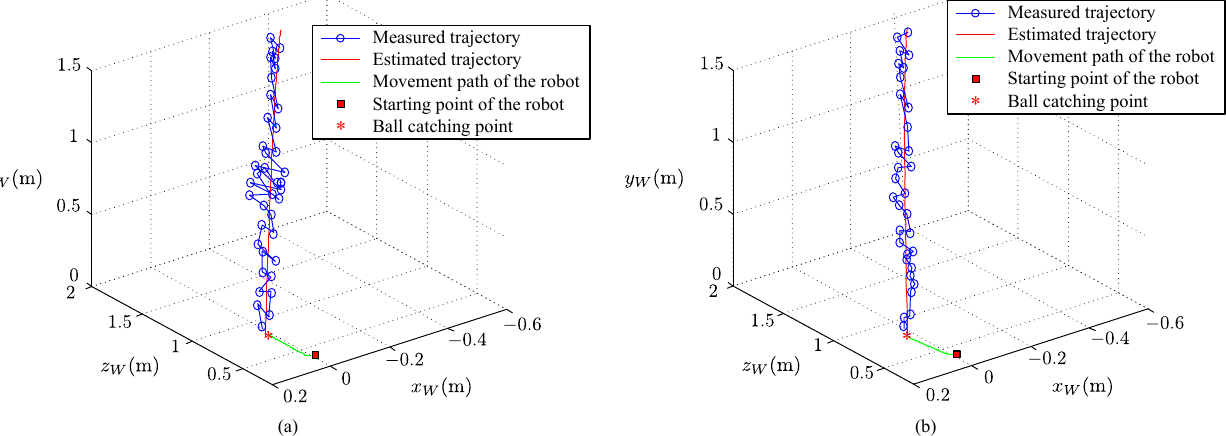
Figure 23. The ball’s trajectories of estimation and measurement, and the robot’s path of movement: ( a ) the previous work and ( b ) this study.